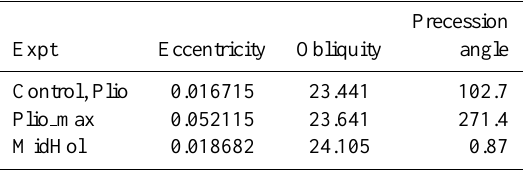
Table 2. Orbital parameters used for the different